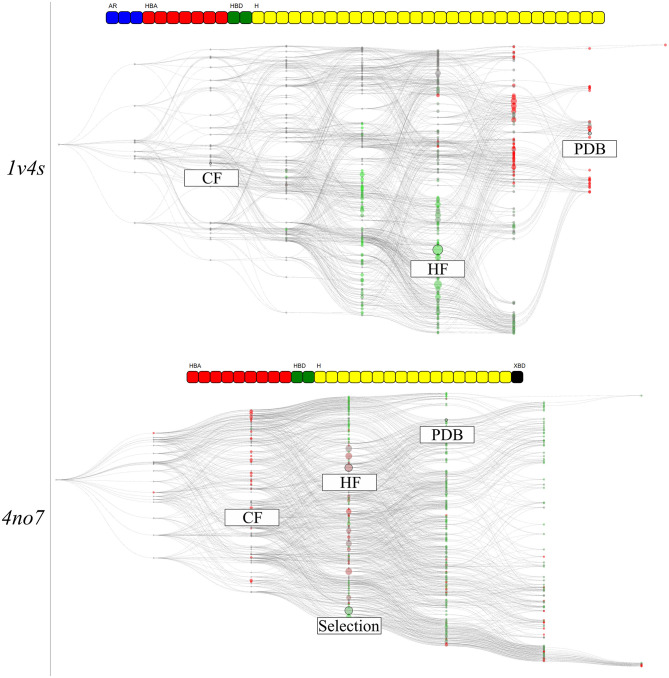
The hierarchical graph of pharmacophore models derived from human glucokinase PDB codes of the 1v4s system is shown on the top, and of the 4no7 system on the bottom. The nodes are colored according to their AUC values at 10% of the database molecules. The greener the node, the closer is its AUC value to 1, and the redder the closer to 0. Nodes with “Artificial” pharmacophore models are colored gray. The nodes corresponding to the pharmacophore models obtained from the PDB structure, from the highest frequency of appearance and with the two common features between the systems are labeled accordingly. Associated feature vectors are shown above the corresponding graphs.